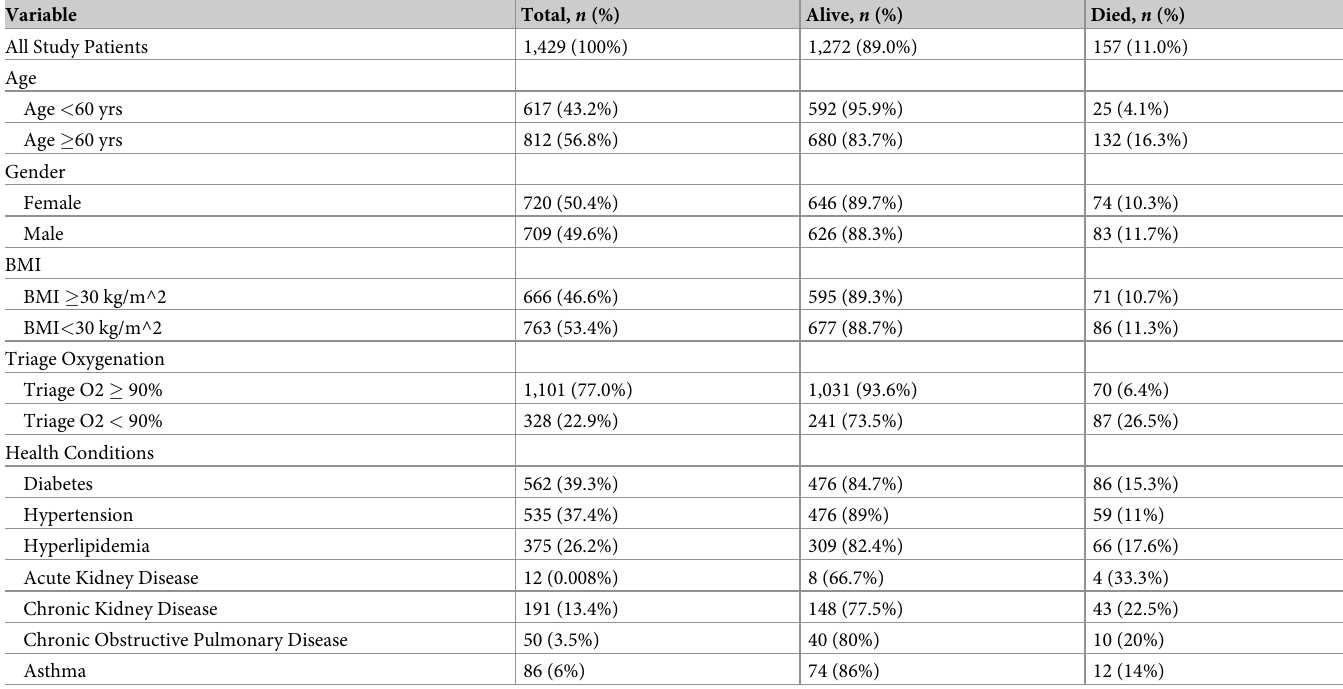
Table 4. Descriptive characteristics of study patients, demographics, and survival status in the prediction tool validation (n = 1,429 patients)